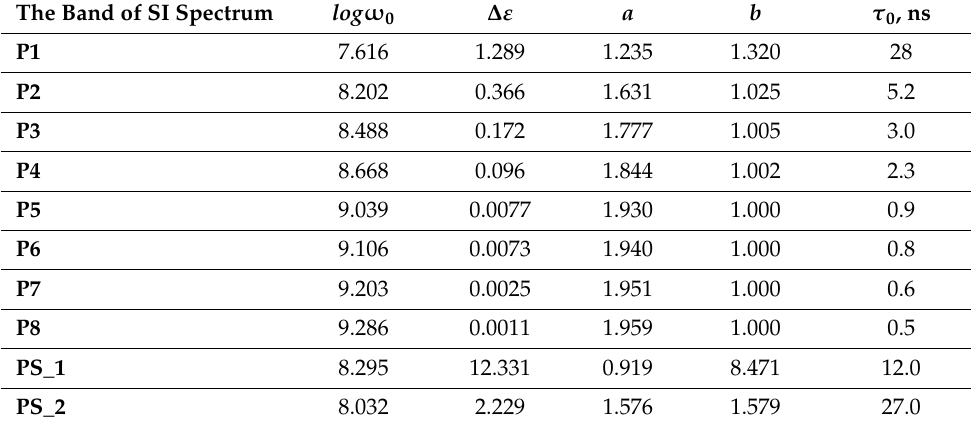
Figure 12. Energy diagram of population inversion of levels T +1 and T − 1 (the length of horizontal segments is proportional to the population of levels when splitting T +1 and T − 1 by the mechanism of spin–spin interaction) (From [48] with permission).